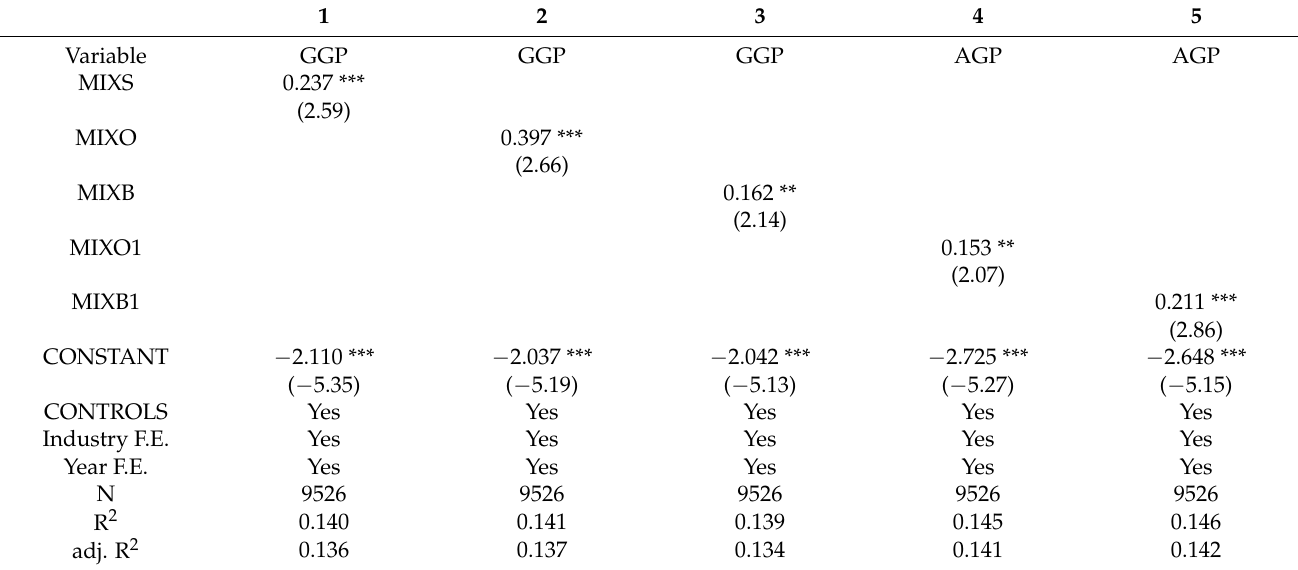
Table 7. Alternative measures of key variables.